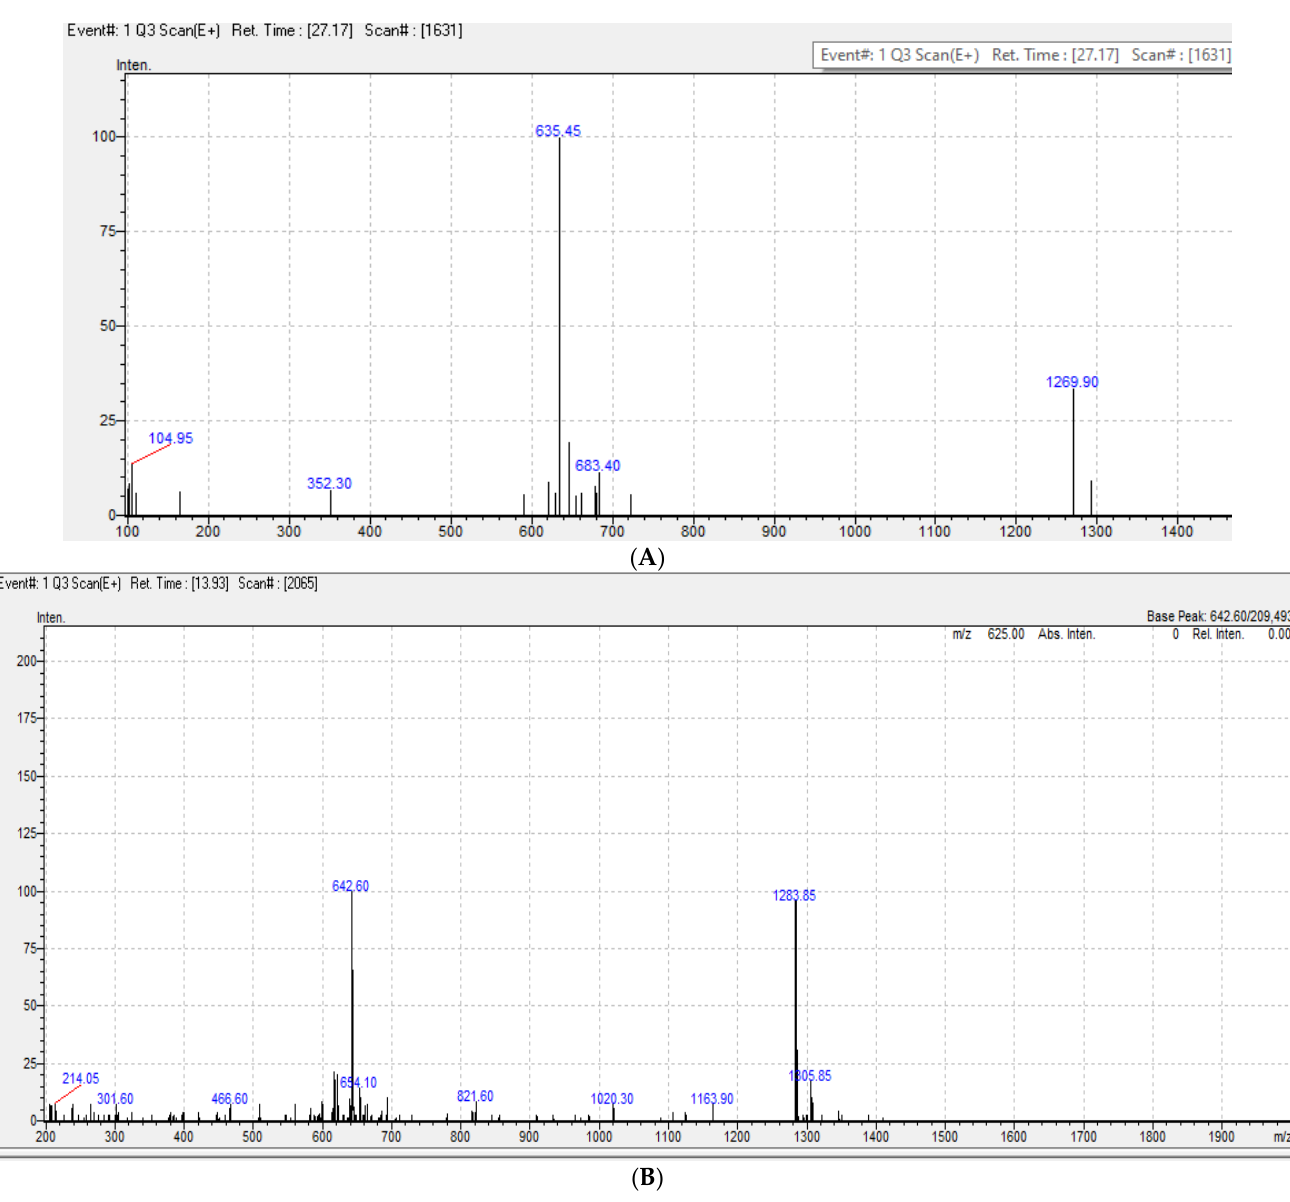
Figure 8. ESI-MS data of compound 3 ( A ) and 4 ( B ). Table 3. One dimension NMR data of compound 3.